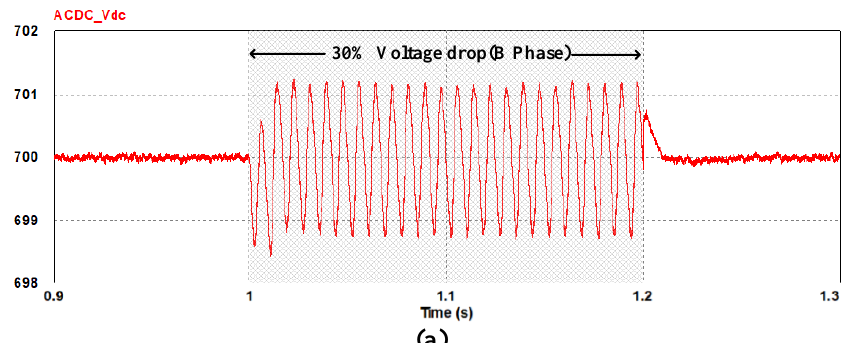
Figure 17. Waveform of voltage when harmonics is included in input side; ( a ) the 3-phase input voltage with harmonic components; and, ( b ) the 3-phase input voltage detected by the SOGI-FLL.